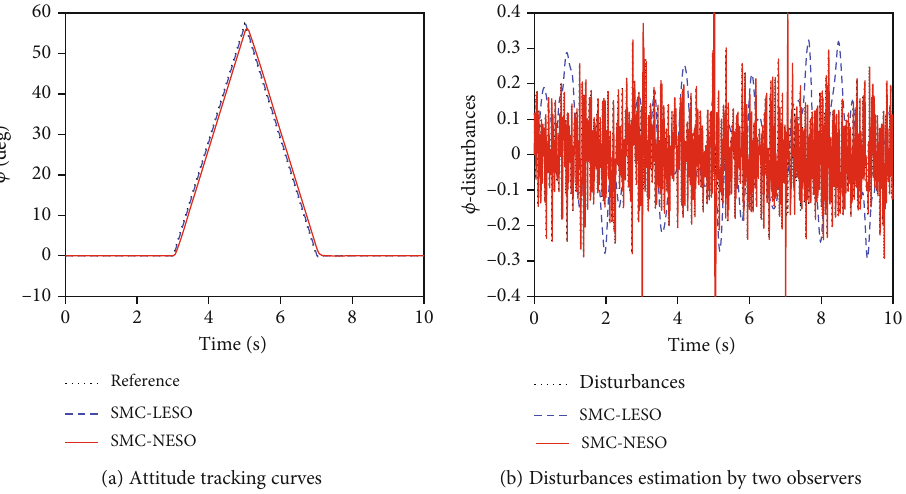
∈ ½ − 0 : 3, 0 : 3 (cid:2) . M